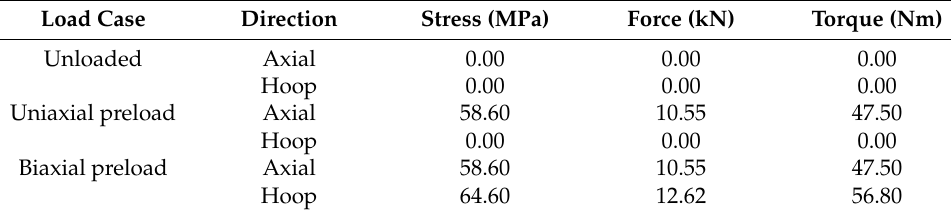
Table 2. Calculated levels of preloading used for the experimental impact testing.